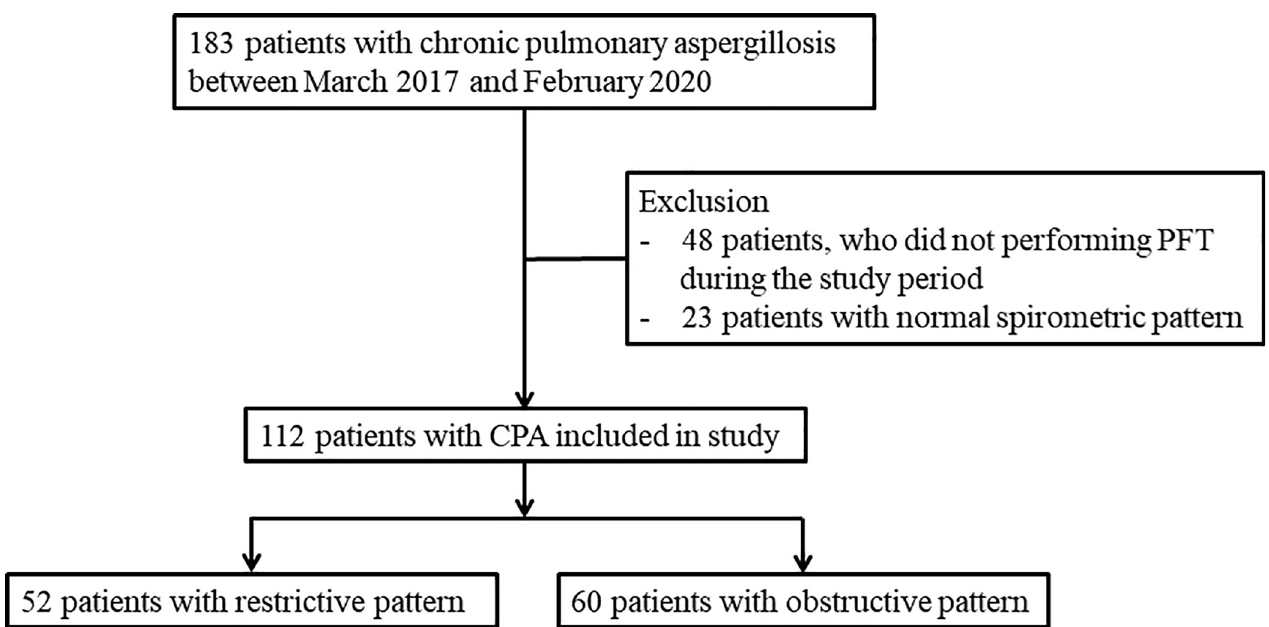
Fig 1. Flow chart of the study population in the study. PFT, pulmonary function test; CPA, chronic pulmonary aspergillosis.